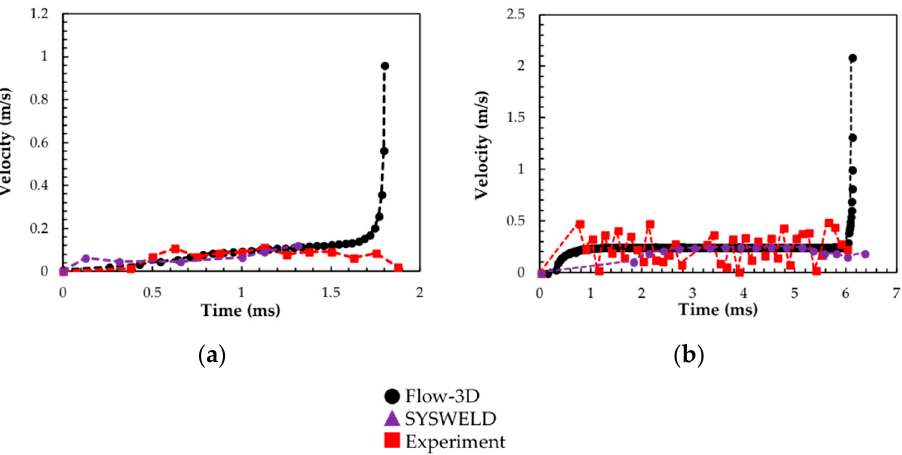
Figure 11. Comparison of solidification velocity at the top of the melt pool predicted by FLOW-3D and SYSWELD and observed in the experiment for ( a ) 139 W spot-melt and ( b ) 53.5 W and 0.25 m/s raster. Note: time = 0 for ( a ) refers to the moment the laser was turned off and time = 0 for ( b ) refers to the moment the laser was turned on and began rastering. Additionally, the laser was turned off at 6 ms in ( b ).